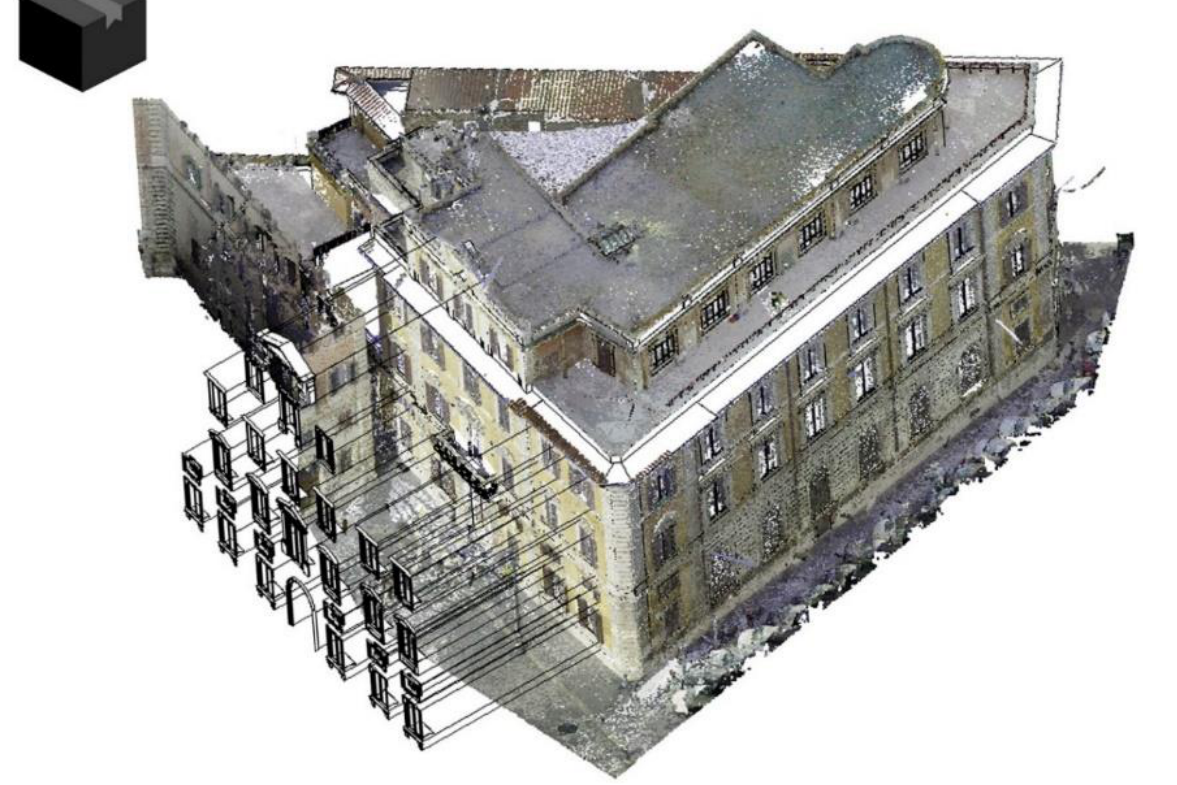
Figure 4. The building in Piazza Borghese, “black box” model.